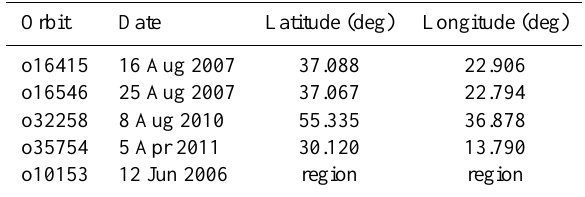
Table 2. Orbits, dates and locations of example